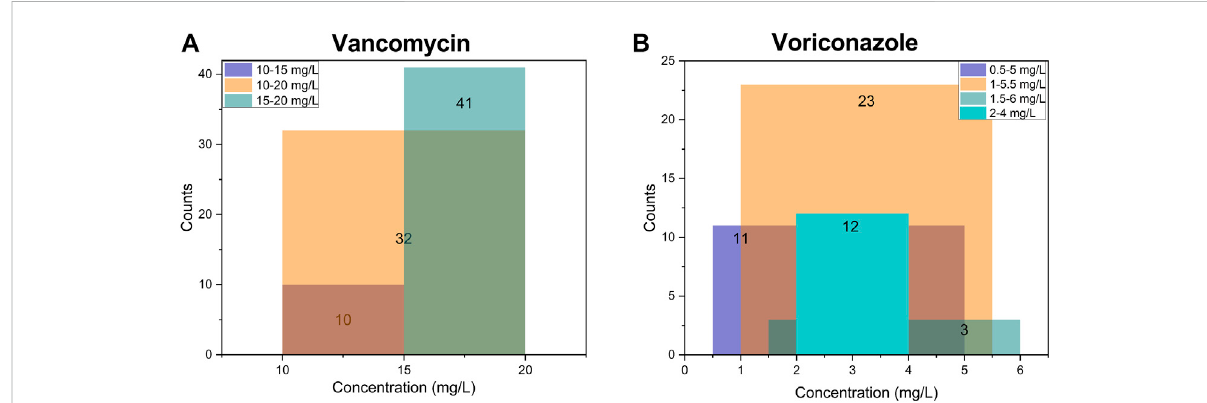
FIGURE 3 The top three target concentration ranges and their overlap in all institutions (N = 99). (A) of vancomycin for adult patients infected with MRSA (N = 90); (B) of voriconazole for adult patients (N = 42), and 12 respondents pursuing 2 – 4 mg/L as the target range considering clinical ef fi cacy and safety in critically ill patients. The numbers on the column represent the respective counts. The color of the overlap will change when the target ranges cross, and the range with the most overlaps means the most common part of the target concentration.